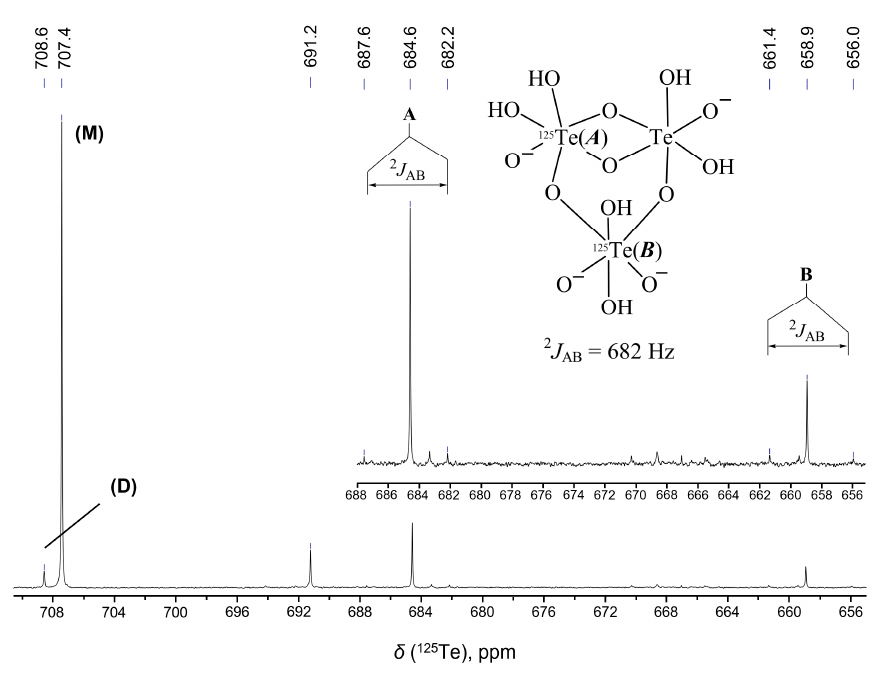
Figure 3. 125 Te NMR spectrum of a tellurate solution ([Te] = 0.2 M, pH